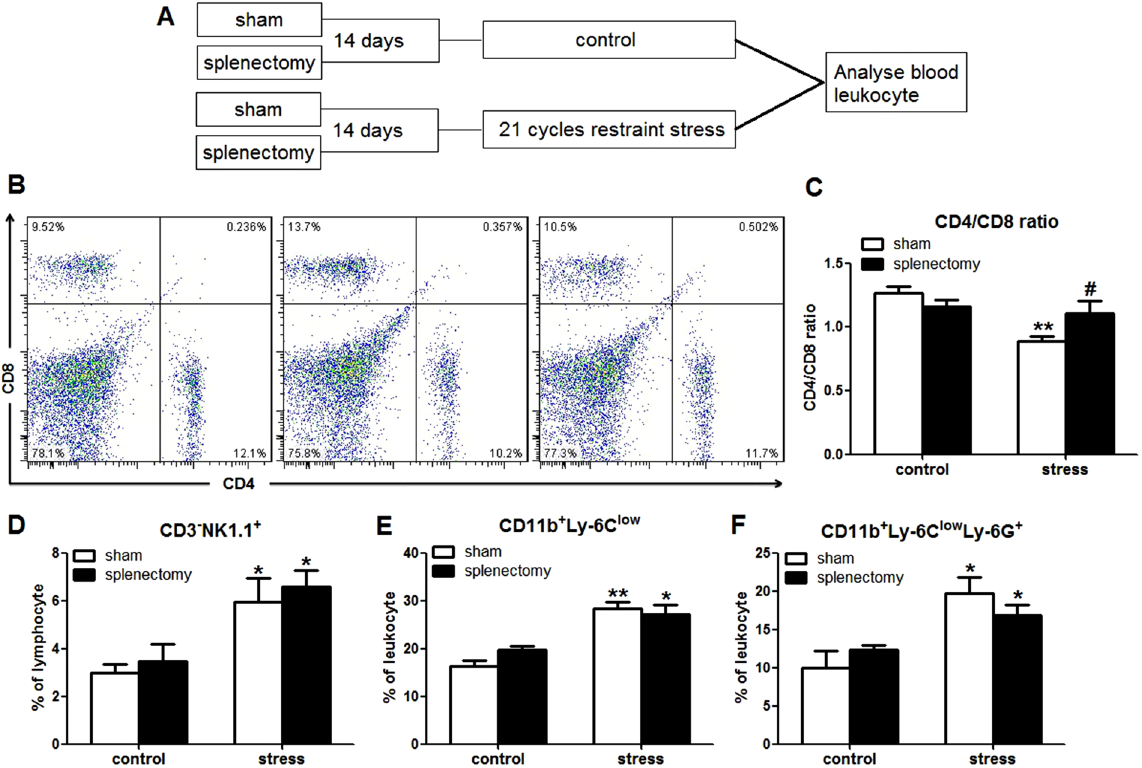
Figure 6. Splenectomy before restraint stress reversed the CD4/CD8 ratio changing following 21 cycles of stress. ( A ) Mice were splenectomized 14 days before restraint stress and then exposed to 21 cycles of restraint stress. ( B ) Representative plots of CD4 + , CD8 + T lymphocytes in blood. ( C ) Splenectomy before restraint stress could attenuate the changes of CD4/CD8 ratio. ( D , E and F ) Splenectomy could not block the changes of NK cells ( D ), CD11b + Ly-6 low monocytes ( E ), CD11b + Ly-6C low Ly-6G + PMN-MDSCs ( F ) induced by restraint stress. Data were shown as mean ± SEM (n = 5–6). * p < 0.05, ** p < 0.01 vs. control. # p < 0.05 vs.